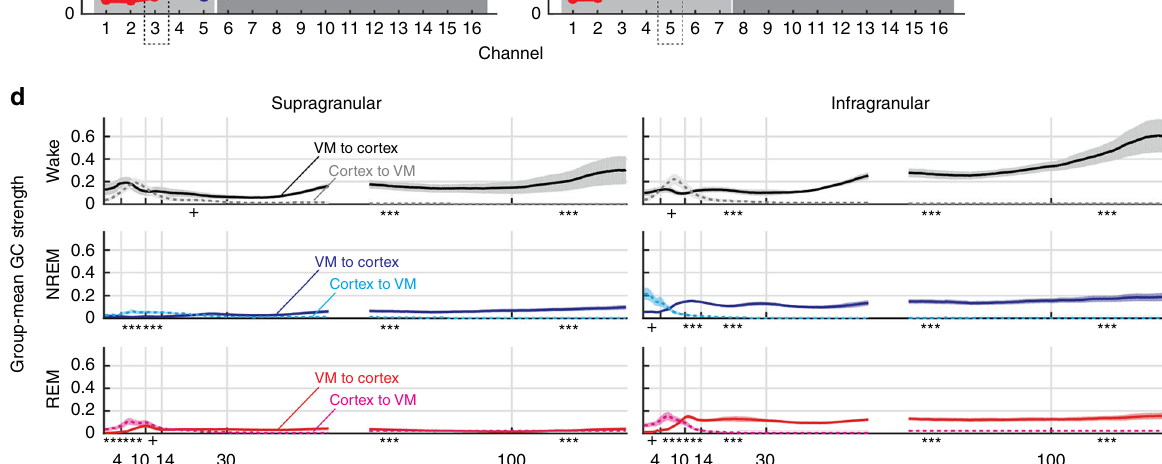
Fig. 5 Vigilance state-dependent Granger Causality (GC) between VM and motor cortex. a Raw traces of temporal GC from M1 or M2 to VM (gray line) and VM to M1 or M2 (black line). b Temporal GC strengths across all cortical channels, in the same mice shown in a . Light or dark shaded area indicates the range of supra- or infra-granular layers, respectively. c Group-mean temporal GC strengths in the supra- or infra-granular layer channels. d Directed causal in fl uence between VM and cortex through distinct frequency channels. In all columns, wake (top), NREM sleep (middle), and REM sleep (bottom). All error bars show standard errors of GC strengths ( n = 5 mice)